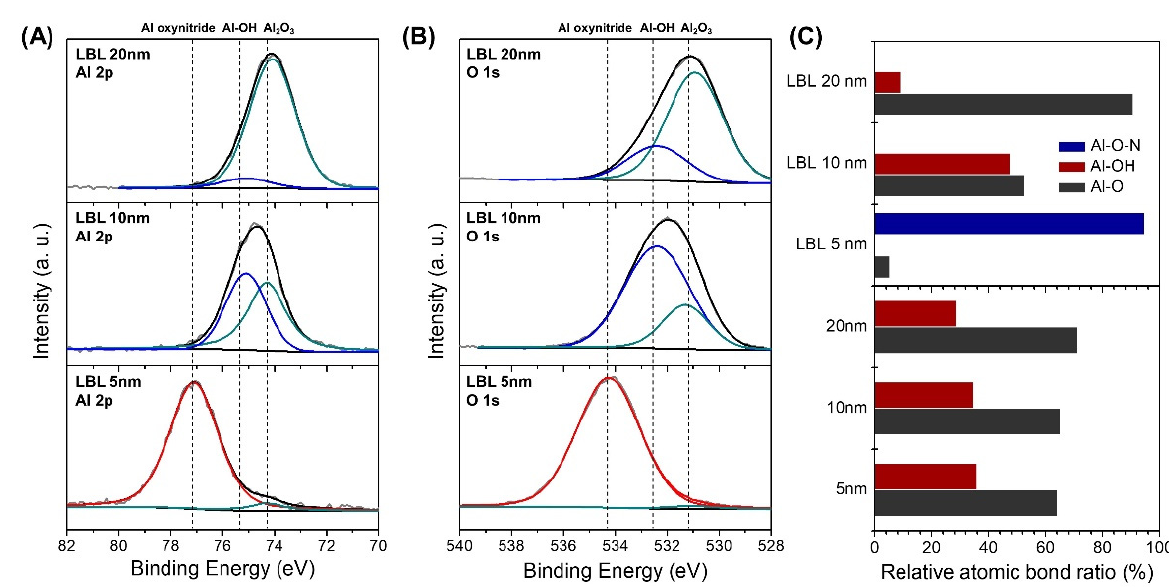
Figure 2. ( A ) Al 2p ( B ) O 1s XPS spectra of LBL Al 2 O 3 ( C ) relative content of atomic bonding in LBL and bare substrate Al 2 O 3.